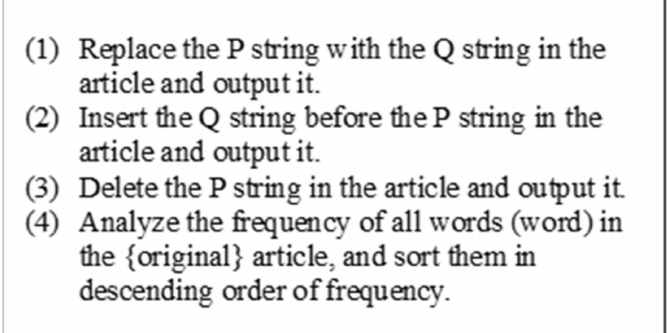
Figure 19. Test question (3).